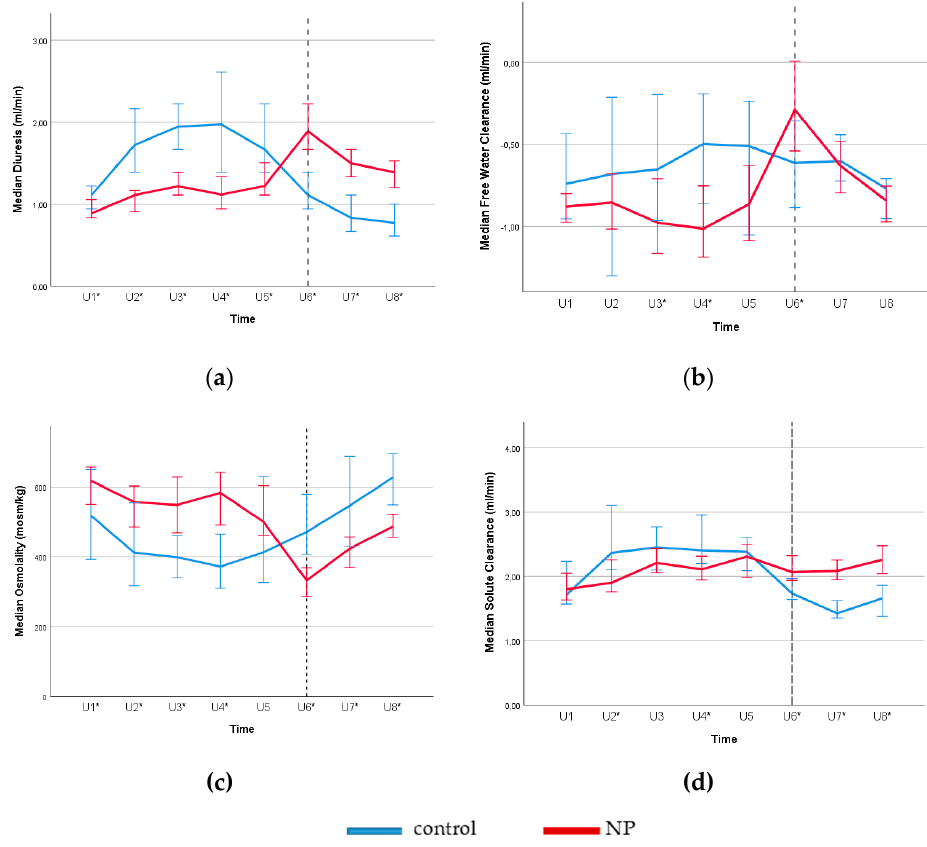
Figure 2. Circadian rhythms for diuresis rate ( a ), free water clearance ( b ), osmolality ( c ) and solute clearance ( d ) for subjects with and without NP (control) according to eight urine samples collected over 24 h. Reference line separates the day and night time. Daytime urine samples were collected between 8–11 a.m. (U1), 11 a.m.–2 p.m. (U2), 2–5 p.m. (U3), 5–8 p.m. (U4), and 8–11 p.m. (U5).